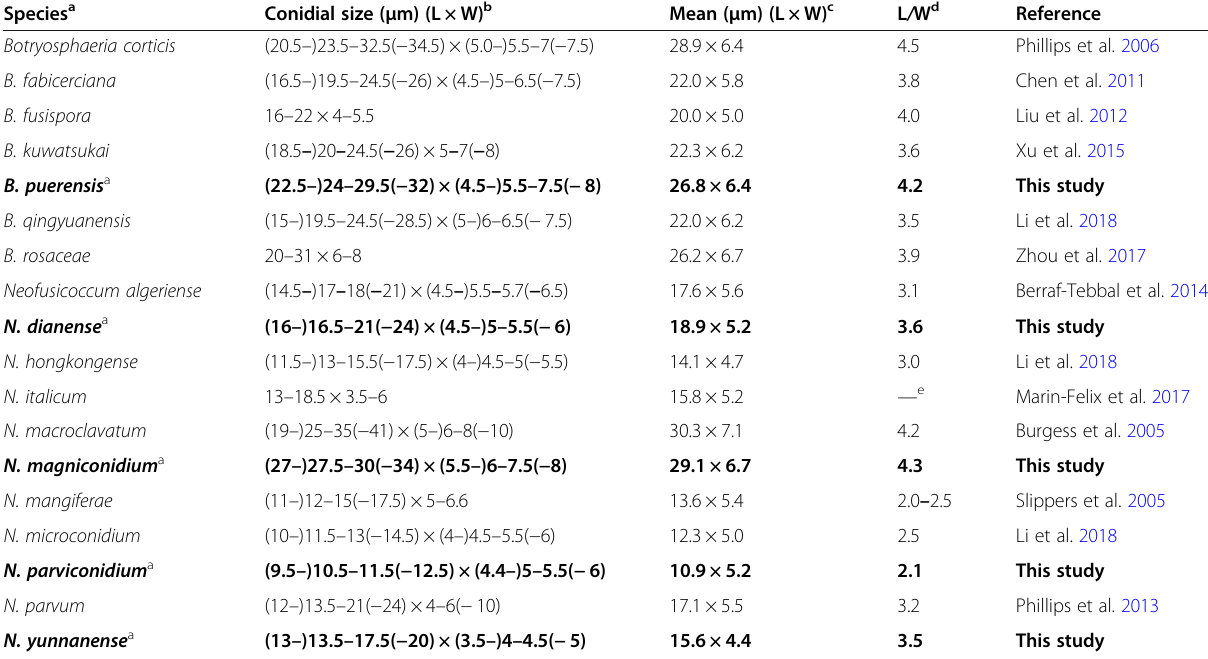
Table 5 Conidial measurements of Botryosphaeriaceae species described in this study and comparison with phylogenetically close species in previous studies Species